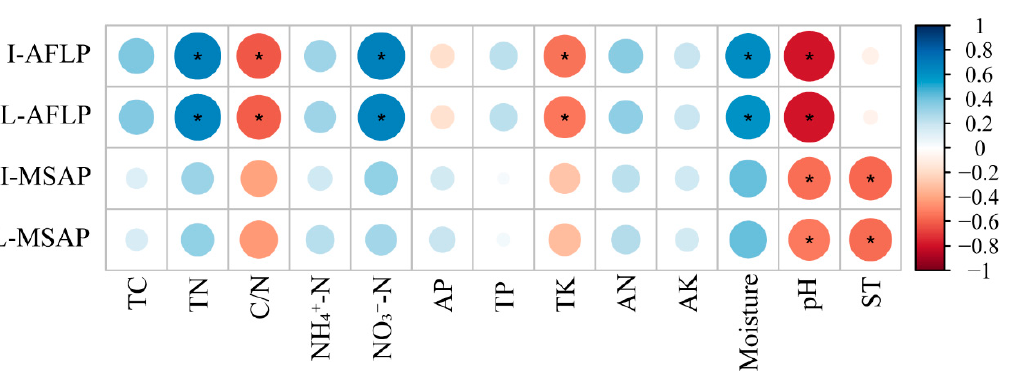
Table 4. Correlation coefficients using Simple Mantel tests across all sites.